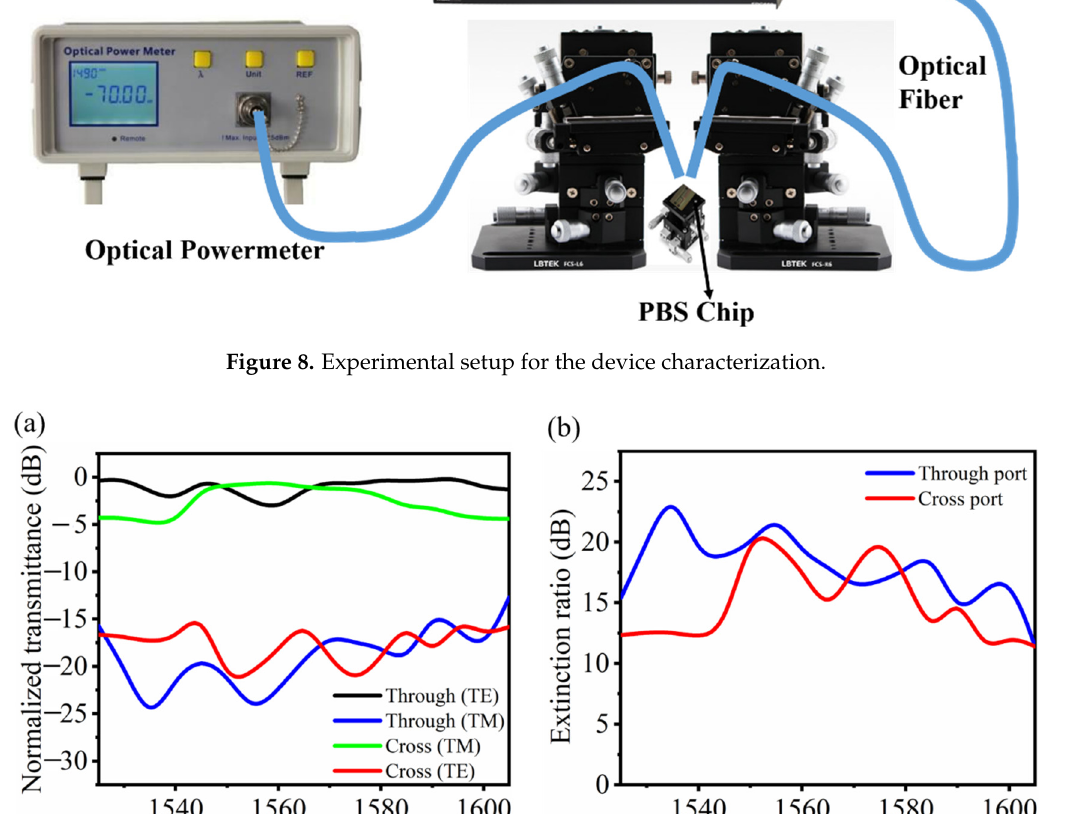
Figure 9. ( a ) Measured normalized transmission spectra of the PBS device and ( b ) corresponding extinction ratio for both polarizations.